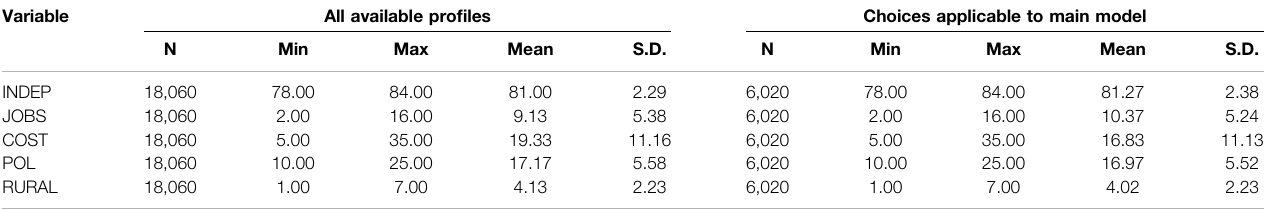
TABLE 5 | Descriptive statistics of independent variables. Variable All available pro fi les